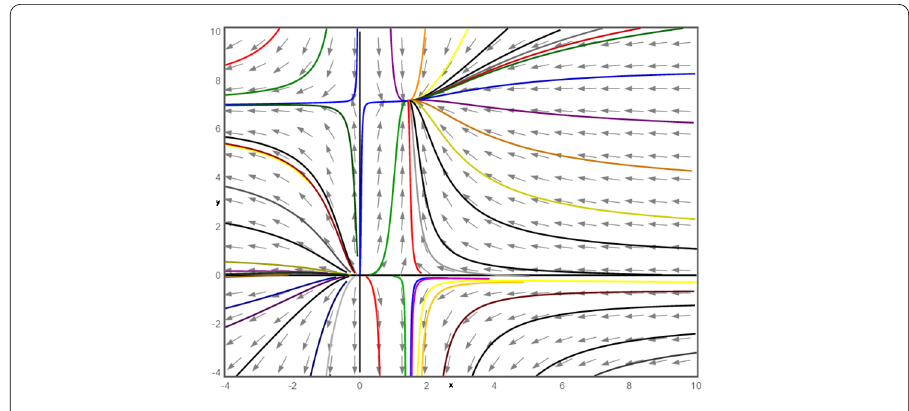
Figure 4 “Good” steady state: l 1 = 1, l 2 = 0